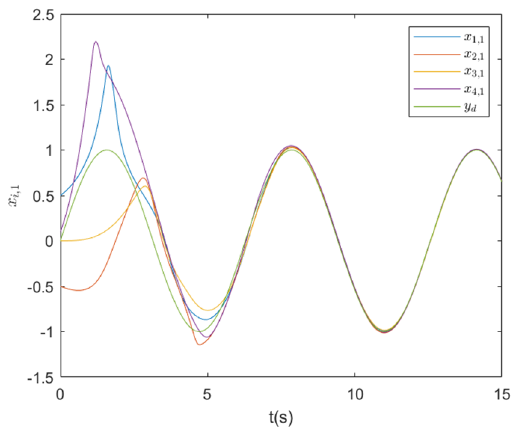
Figure 2. Tracking errors